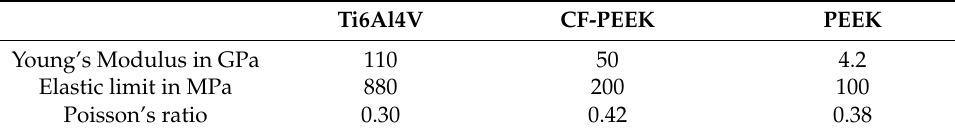
Table 1. Mechanical properties of the materials used in the FE model [25]. Ti6Al4V CF-PEEK PEEK Young’s Modulus in